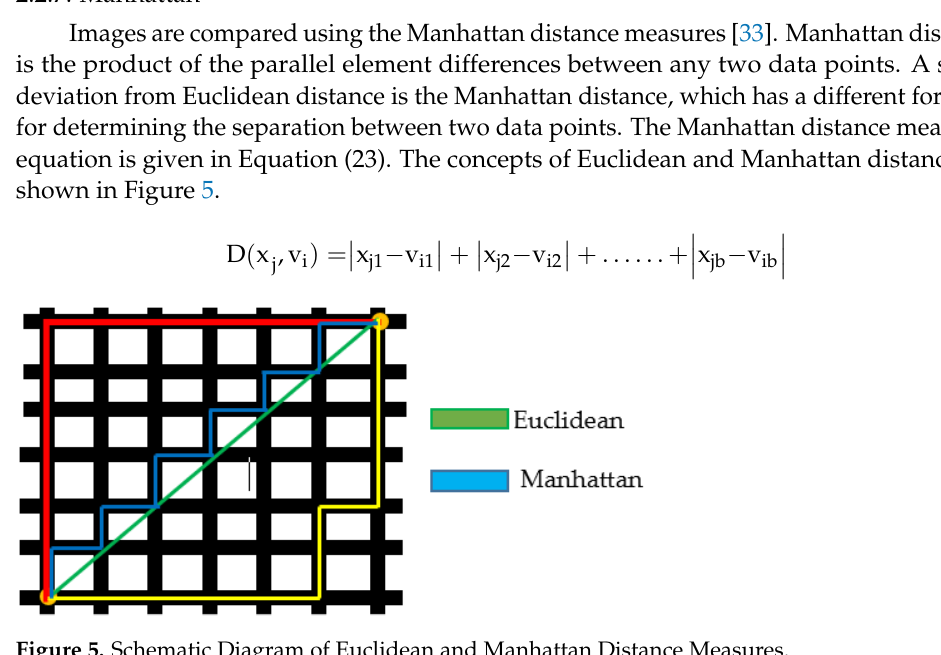
Figure 5. Schematic Diagram of Euclidean and Manhattan Distance Measures.